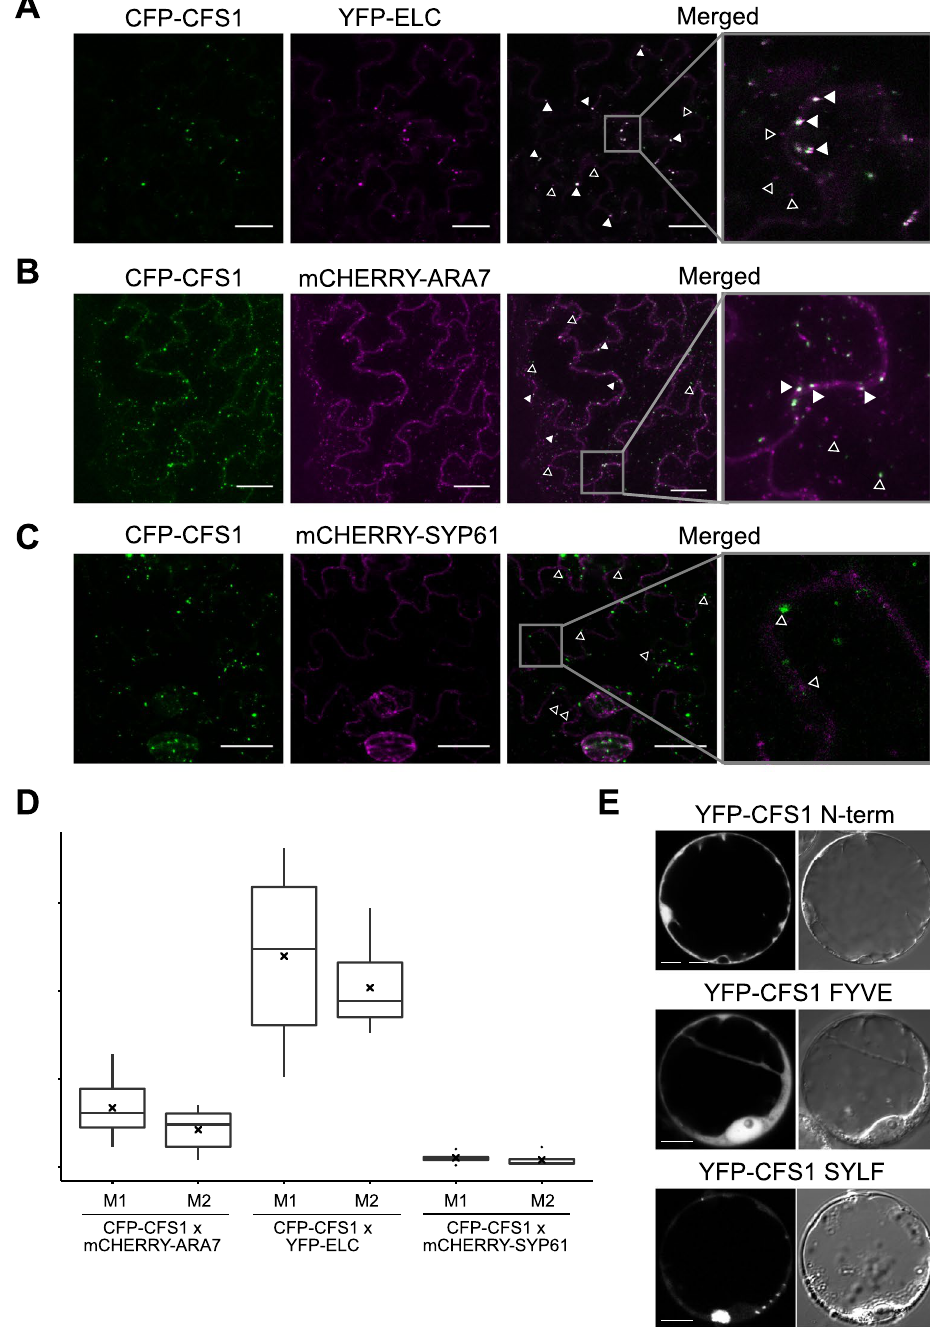
Figure 4. CFS1 SYLF domain mediates CFS1 localization on late endosome. ( A ) CFS1 co-localizes with the ESCRT-I component, ELC. Images are maximum Z-projection from representatives of two independent CFS1 transgenic lines. Arrowhead indicates co-localization. Scale bars: 25 µ m. ( B ) CFS1 co-localizes with the late endosome marker, ARA7. Images are maximum Z-projection from representatives of two independent CFS1 transgenic lines. Arrowhead indicates co-localization. Scale bars: 25 µ m. ( C ) CFS1 did not co-localize with the early endosome marker, SYP61. Images are maximum Z-projection from representatives of two independent CFS1 transgenic lines. Open arrowhead indicates non-colocalizing structure. Scale bars: 25 µ m. ( D ) Manders’ overlap coefficient 67 of transgenic lines co- expressing CFS1 and ARA7, ELC and SYP61 as shown in 4 A–C . M1 indicates the fraction of CFS1 signal that overlapped with the marker of interest, and M2 indicates the fraction of the marker of interest that overlapped with CFS1 signal. Straight lines within boxes represent median, crosses represent mean value, and outliers are depicted as closed circles. Values were obtained from 5 cells originated from two independent transgenic lines. ( E ) CFS1 N-terminal fragments with and without FYVE domain show cytoplasmic localization (YFP-CFS1 N-term and YFP- CFS1 FYVE, respectively); whereas the SYLF domain localizes in punctuate structures. A bright field image is shown to the right of the corresponding images from fluorescent channel. Scale bars: 5 µ